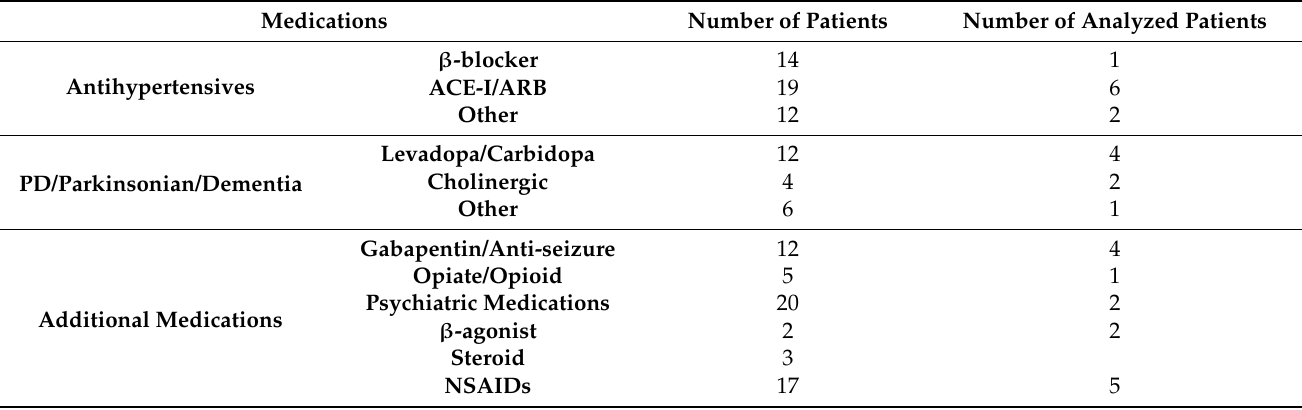
Table 2. Patient-reported medications with number of total patients and analyzed patients taking each